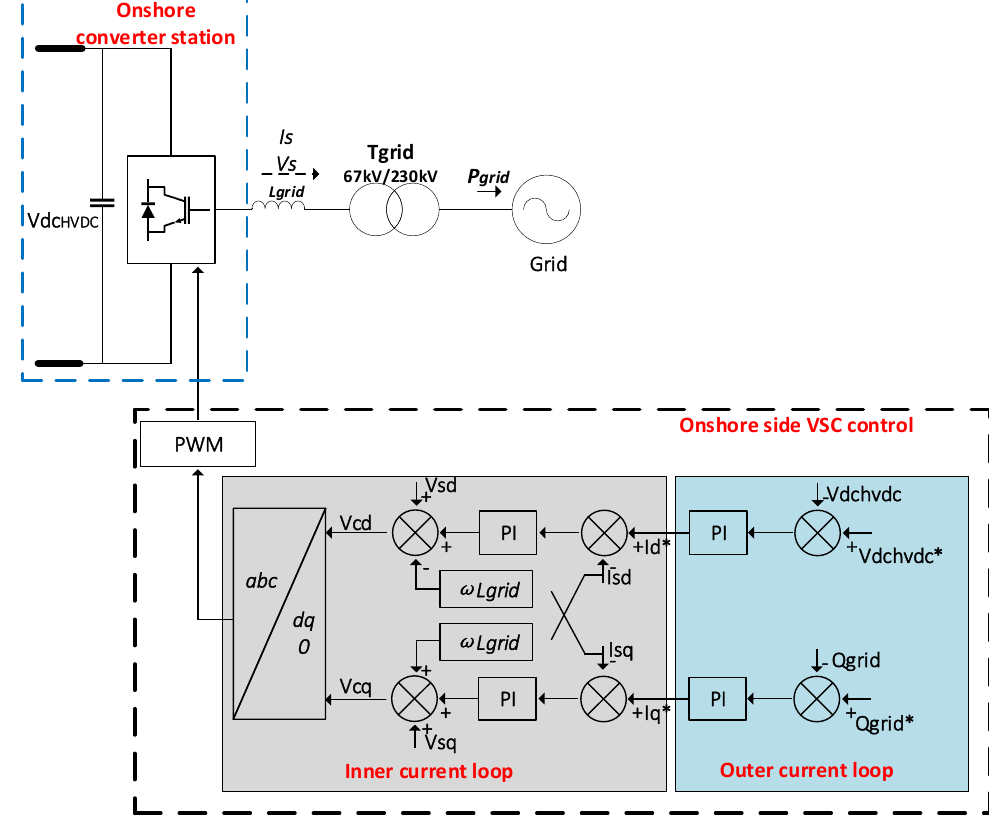
Figure 2. Control block diagram of the onshore two-level voltage source converter (ON-VSC).